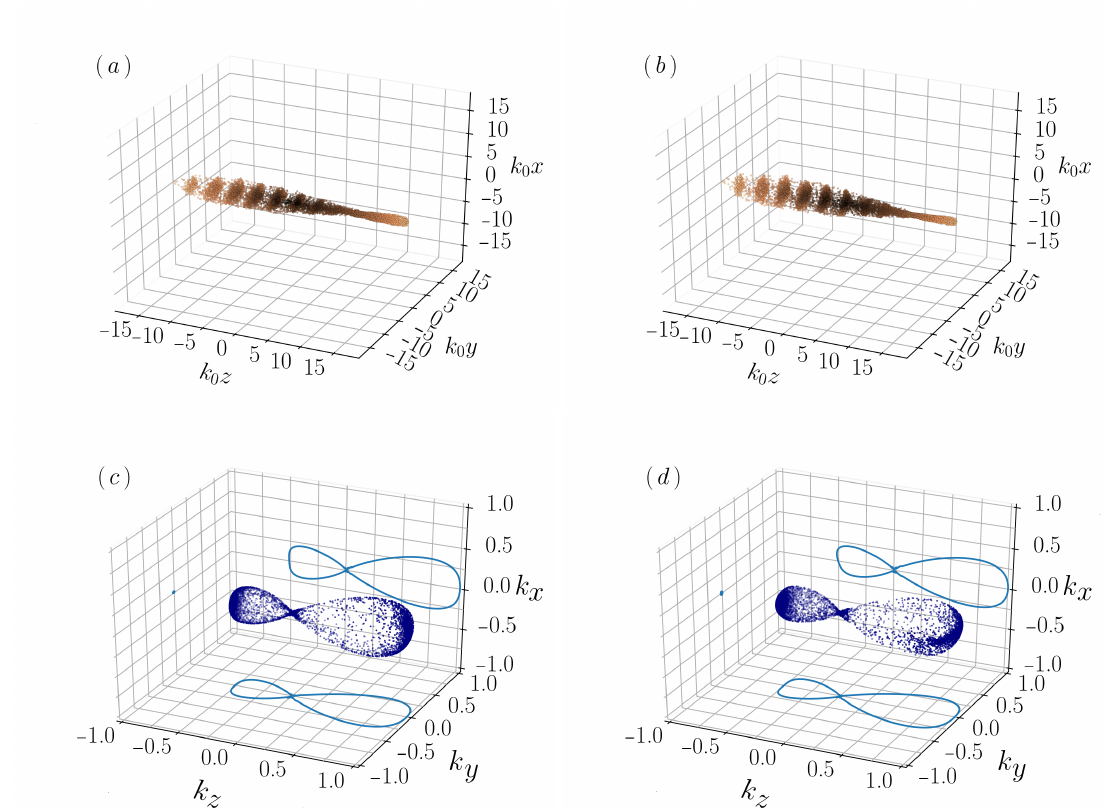
Figure 7. Collective scattering and pattern formation from an ellipsoidal 3D atomic cloud with N = 10 4 , with random initial positions, irradiated by a pump field propagating parallel to its major axis and linearly polarized. The snapshots at t = 0.170 ω − 1 r are shown for a pump polarization along the x axis, ( a ), and along the y axis, ( b ). The corresponding snapshots of the bunching factors are shown in ( c , d